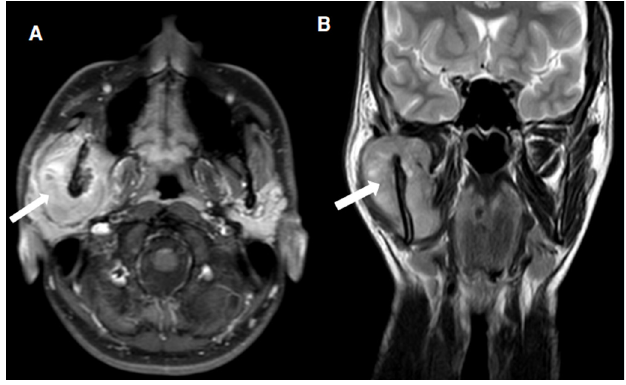
Fig. 1. (A and B) MRI image sections: Post Contrast T1 Fat Saturated Axial sections showing heterogenous post-contrast enhancement; Coronal T2 showing hypertense lesion involving the right condyle and adjacent soft tissue (indicated by white arrows).